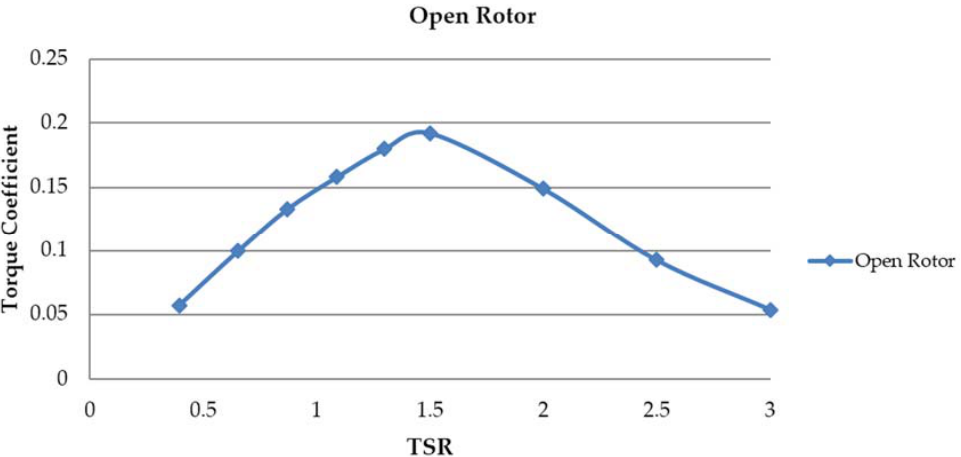
Figure 19. Average C Q for different TSR s.